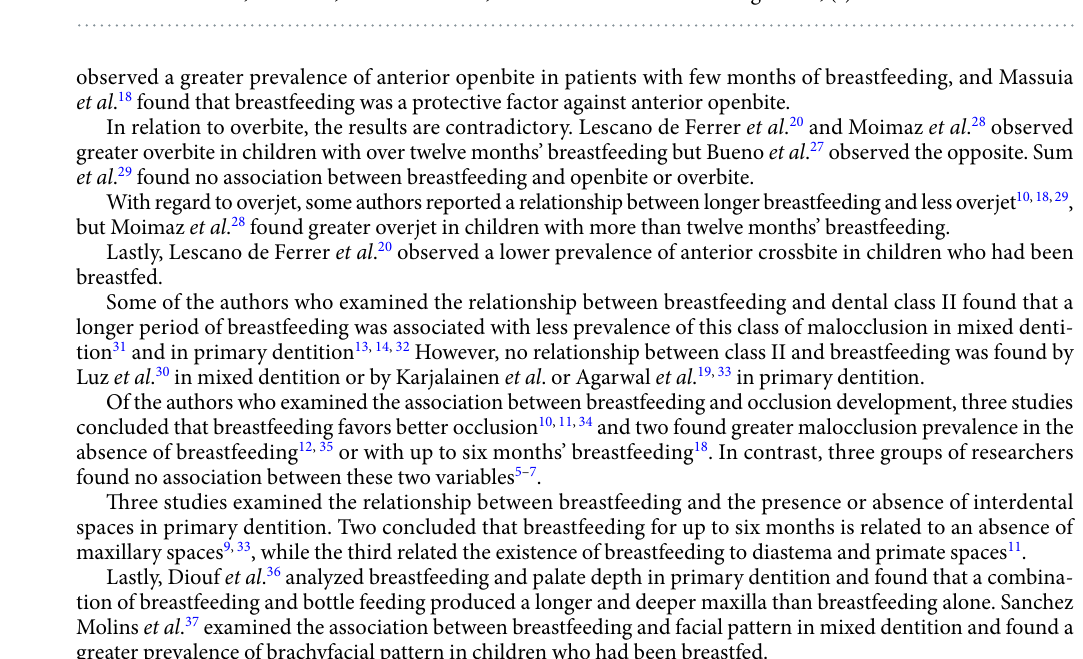
Table 1. Characteristics of articles studying the relationship between breastfeeding and malocclusion in mixed dentition. M: male, F: female, OR: Odds Ratio, NNSH: non-nutritive sucking habits, (-): no